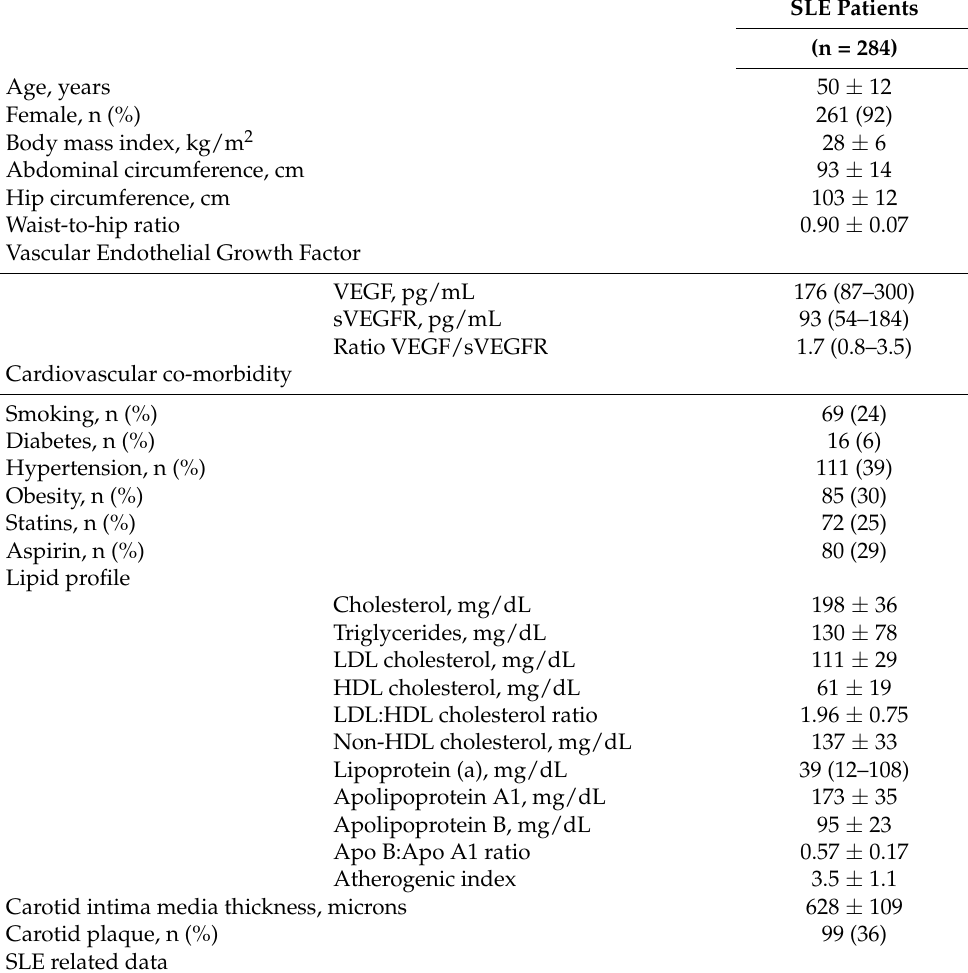
Table 1. Characteristics of SLE